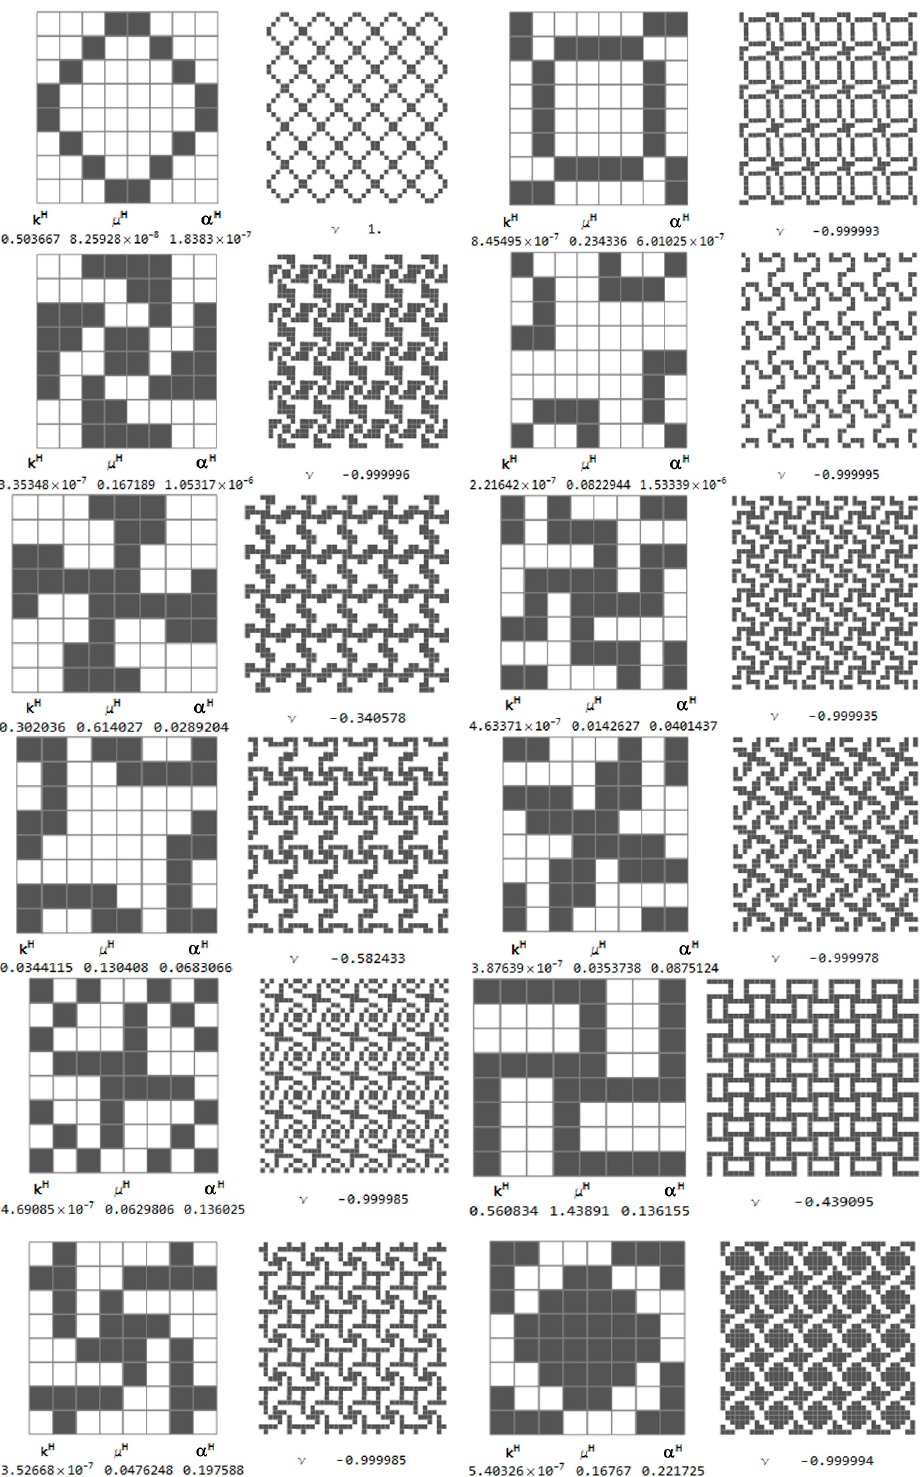
Figure 15. Selected auxetic 1st rank cubic microstructures and the effective moduli. Cells of periodicity, and images upon their tessellated patterns.